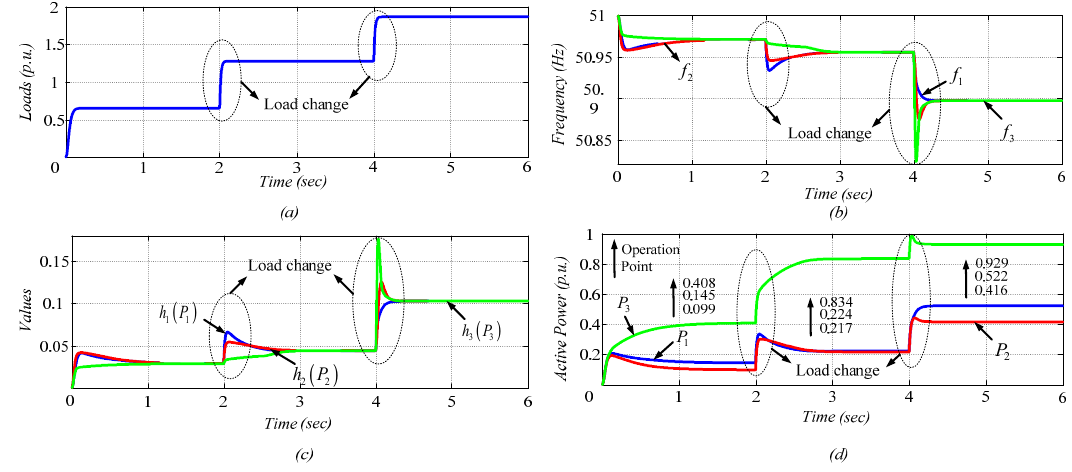
h P ; and ( d ) active power output of DGs. i i